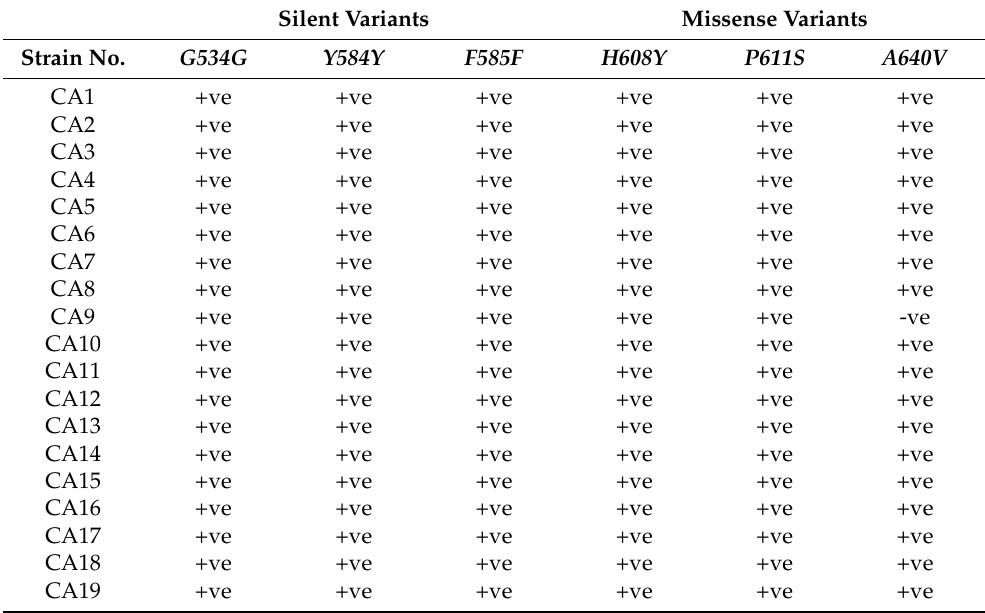
Table 2. List of missense and silent variants identified in TAC1B gene of Candida auris isolates. Silent Variants Missense Variants Strain No. G534G Y584Y